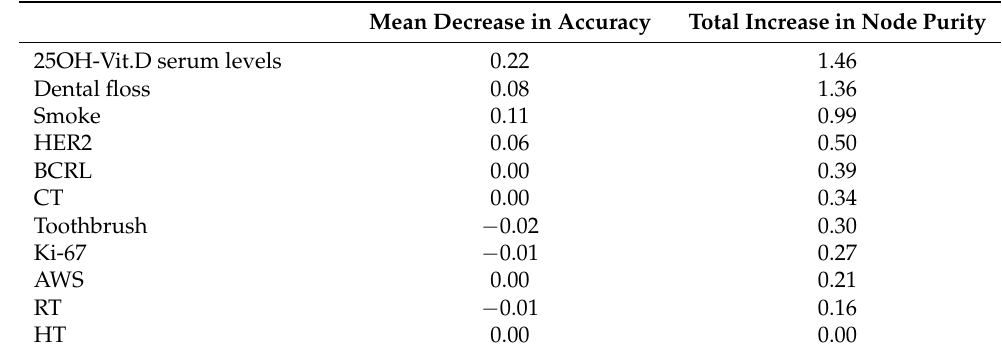
Table 5. Variable importance in regression random forest model in terms of correlation with Decayed, Missing, and Filled Permanent Teeth Index